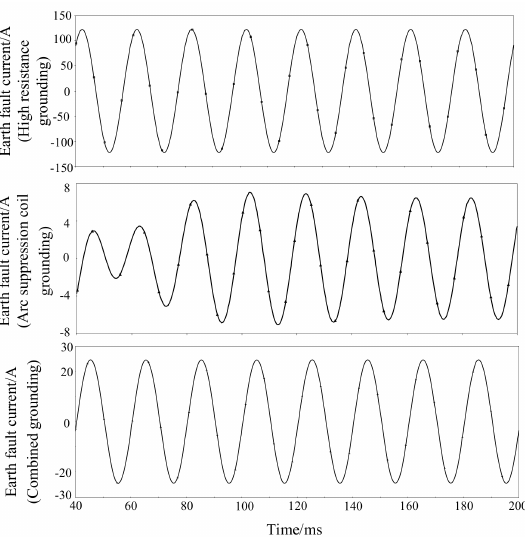
Figure 5. Fault current waveform in the case of single-phase grounding fault.